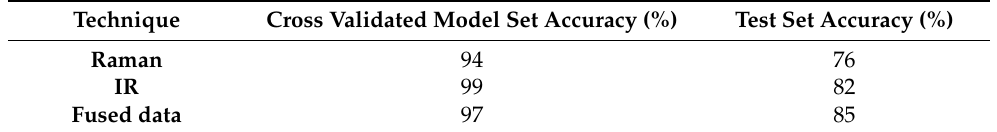
Table 1. SVM model performance with the accuracy of model set and independent test set using Raman, IR, and the fused